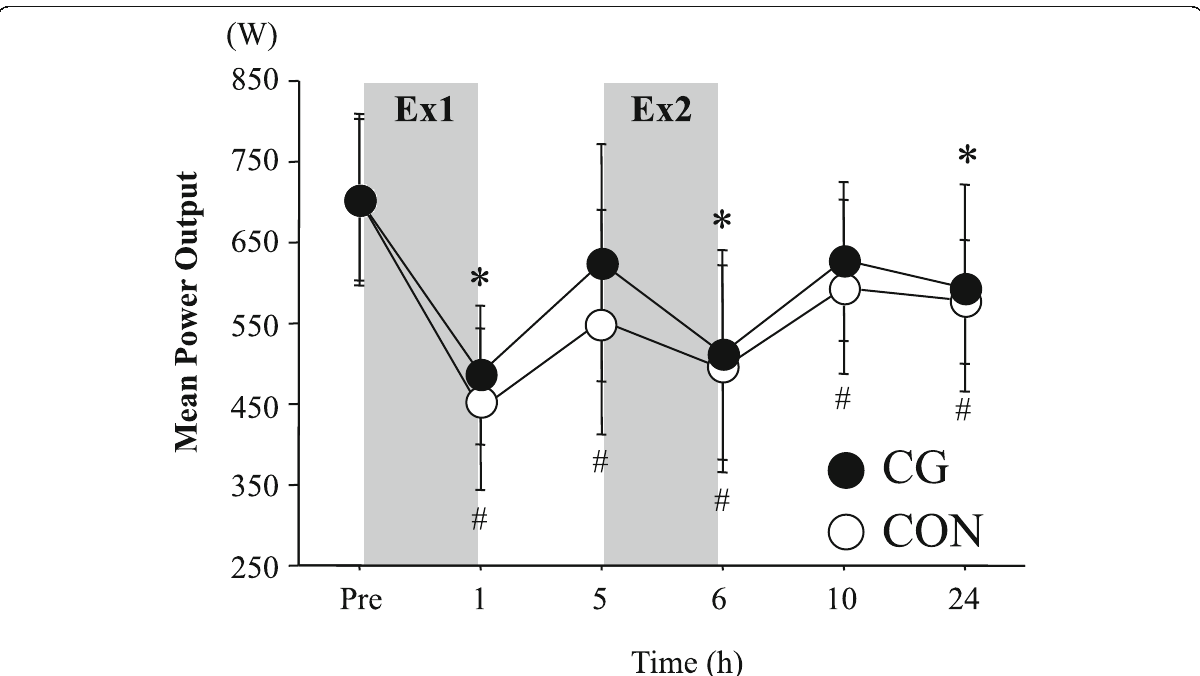
Fig. 2 Mean power output for bench press exercise. Shaded boxes indicate duration of exercises. Values are means± SD. * P < 0.05 vs. Pre (CG); # P < 0.05 vs. Pre